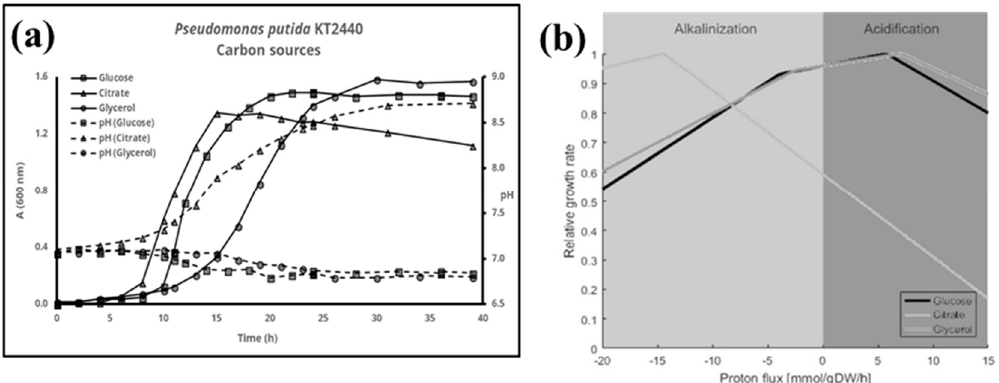
Figure 3. ( a ) Cell-growth (solid lines) and evolution of the pH during bacterial growth of P. putida KT2440 in M63 media supplemented with different carbon sources. The initial pH was 7.0. ( b ) Evaluation of the growth ratio as a function of proton exchange for media with glucose, citrate and glycerol like carbon source using iJN1411 as genome scale model